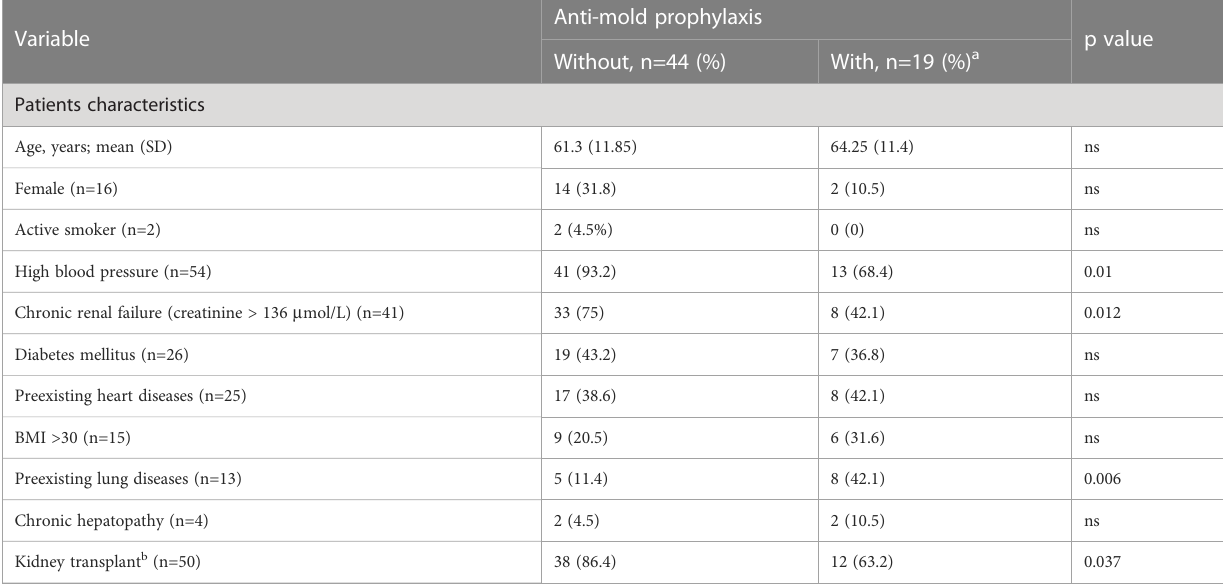
TABLE 1 Comparison between SOTRs with and without anti-mold prophylaxis at ICU admission for COVID-19.